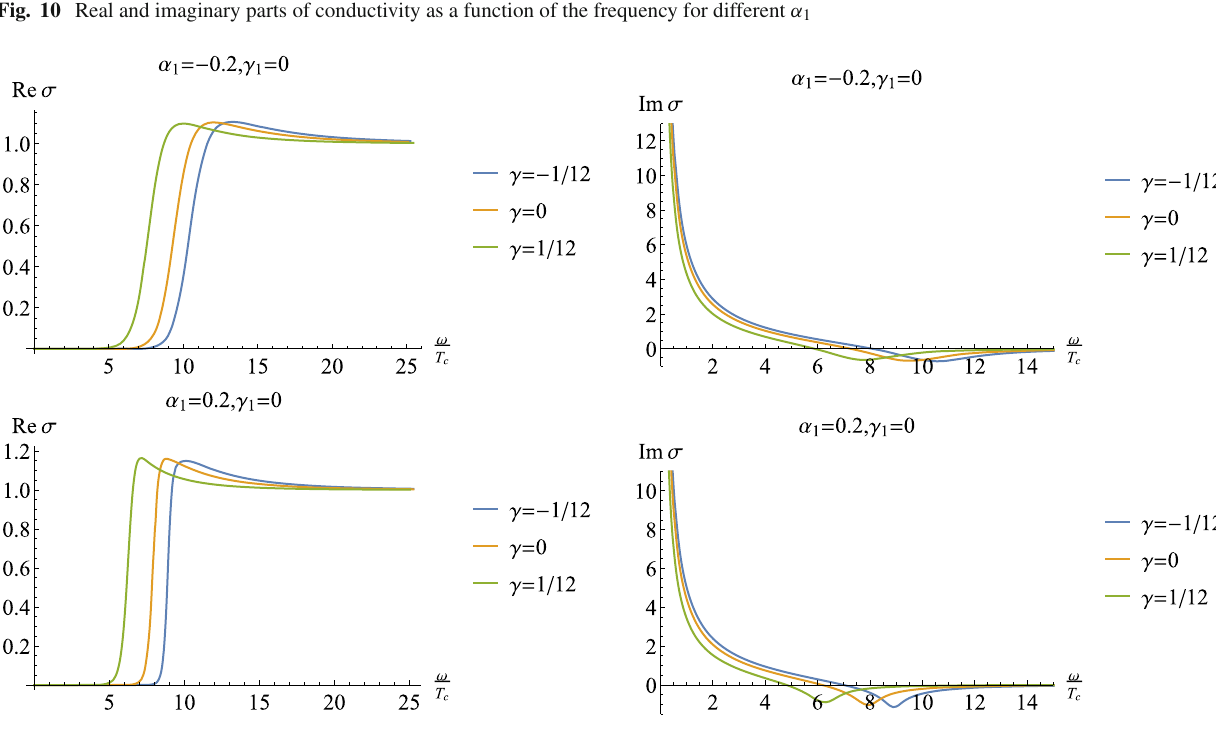
Fig. 11 Real and imaginary parts of conductivity as a function of the frequency for different